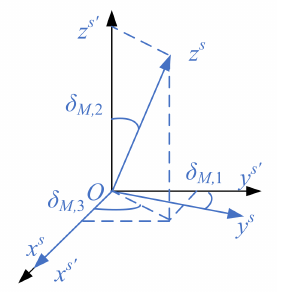
Figure 1. Schematic diagram of non-orthogonal